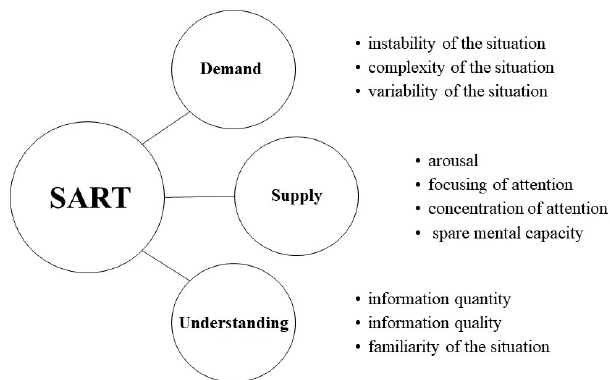
Figure 2. The structure of the situation awareness rating technique.